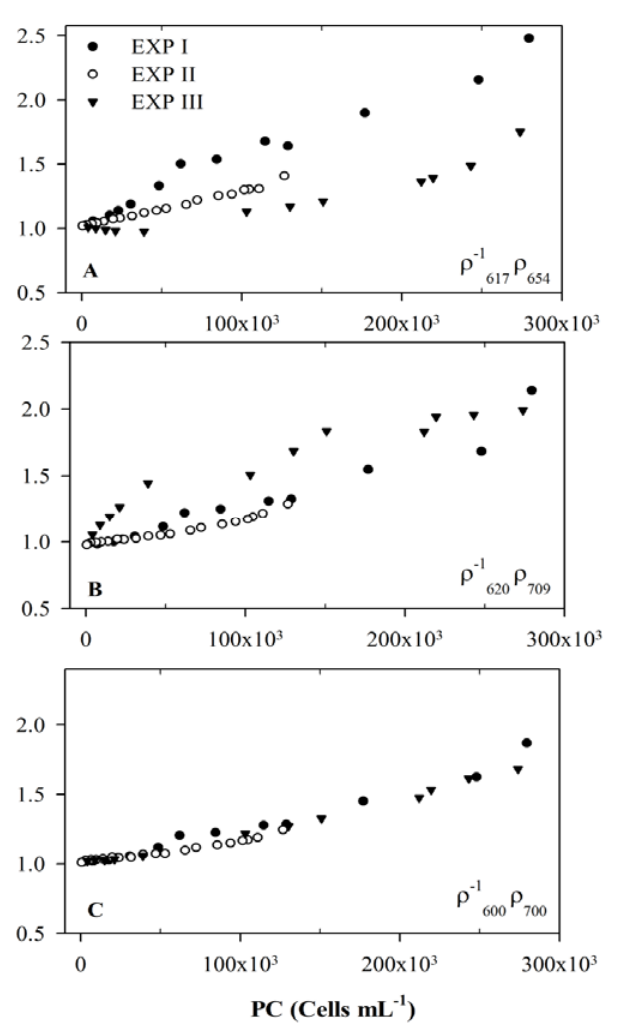
    6541 7091   B.   and C. 617 620